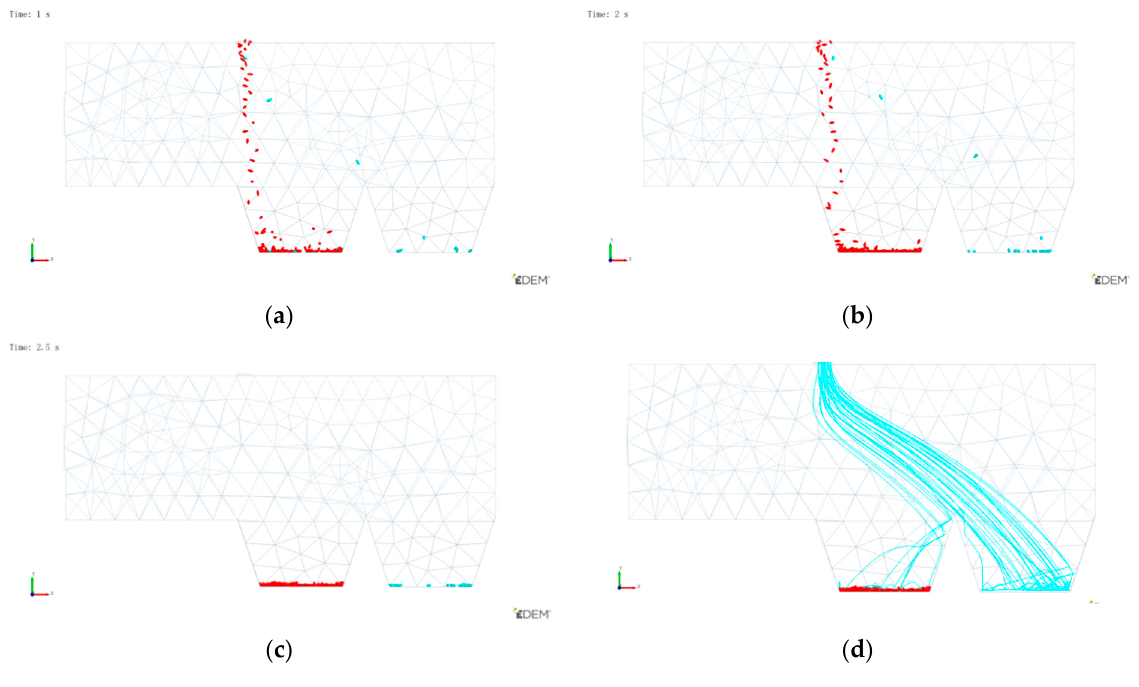
Figure 6. Distribution state and track of grain at different time cut-off points: ( a ) t = 1 s; ( b ) t = 2 s; ( c ) t = 2.5 s; ( d ) motion trajectories of unfilled grains.